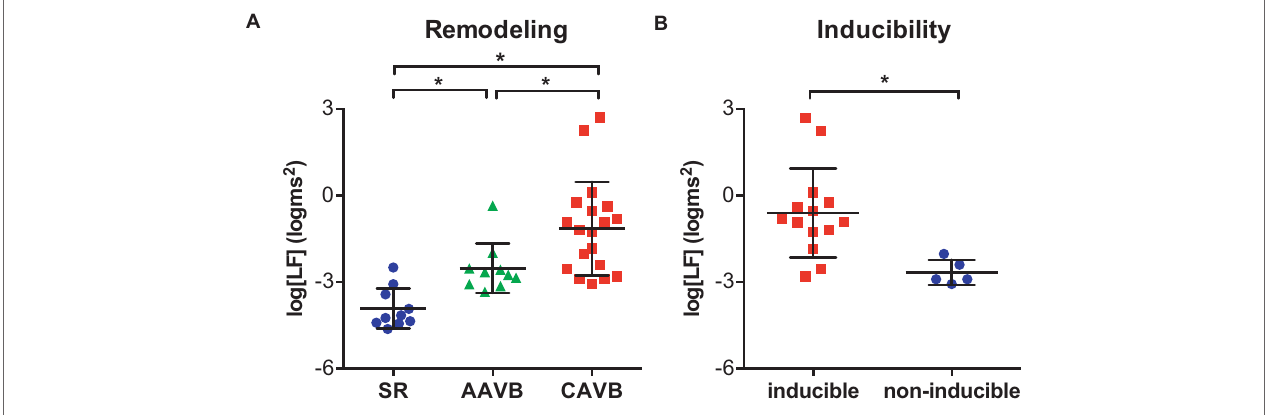
FIGURE 3 | Low-frequency (LF) oscillations of monophasic action potential duration. (A) The logarithmic transformed power of LF oscillations of APD (log[LF]) at sinus rhythm (SR), acutely after AV block (AAVB), and at chronic AV block (CAVB). (B) log[LF] of the inducible vs. the non-inducible CAVB dogs. * p <